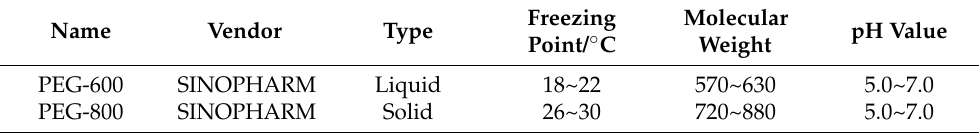
Table 3. Properties of phase change materials provided by the